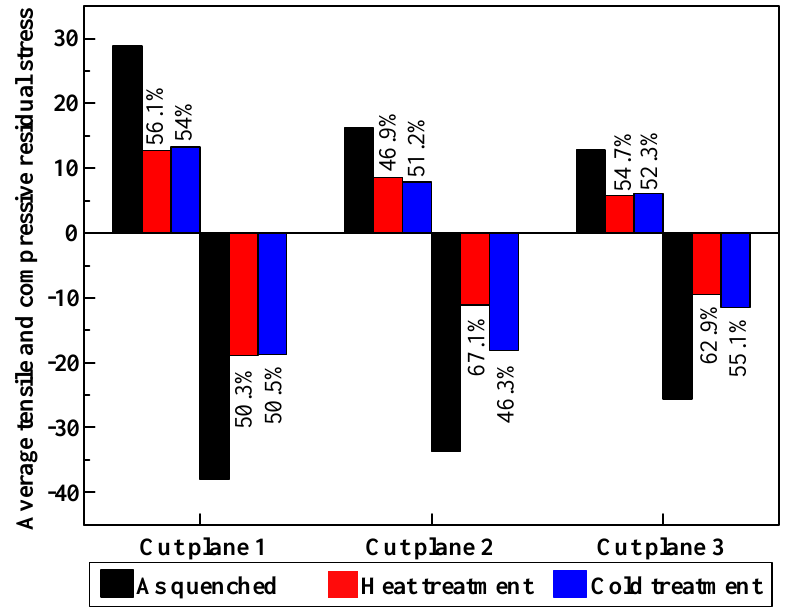
Figure 14. Average tensile (+) and compressive (−) residual stress in different cut planes with three treatment processes. The percentage means the maximum stress reduction of heat and cold post-treatment compared with as-quenched specimen.